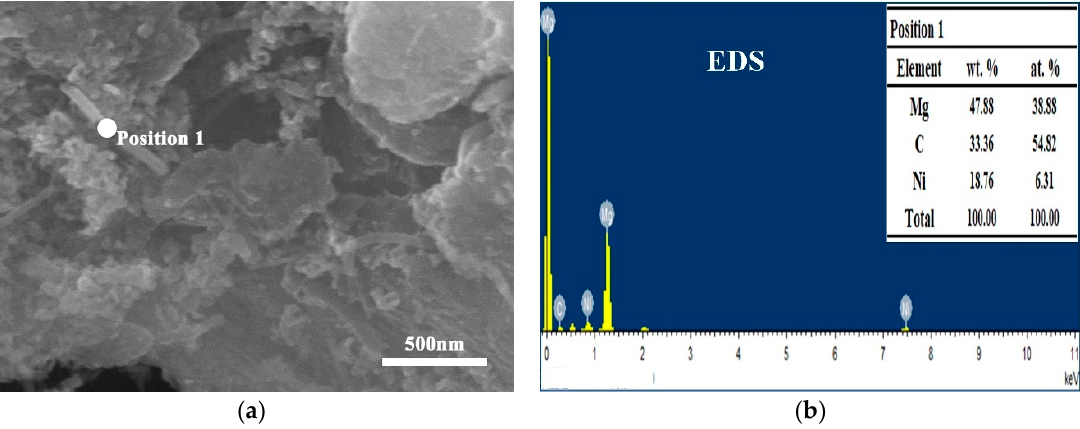
Figure 4. EDS point result from CNTs/Mg composites fabricated from Mg powder grinded for 60 h, ( a ) EDS location and ( b ) EDS result.